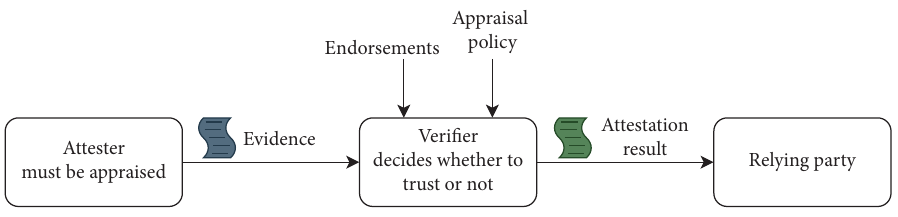
Figure 2: General remote attestation procedure as defined in